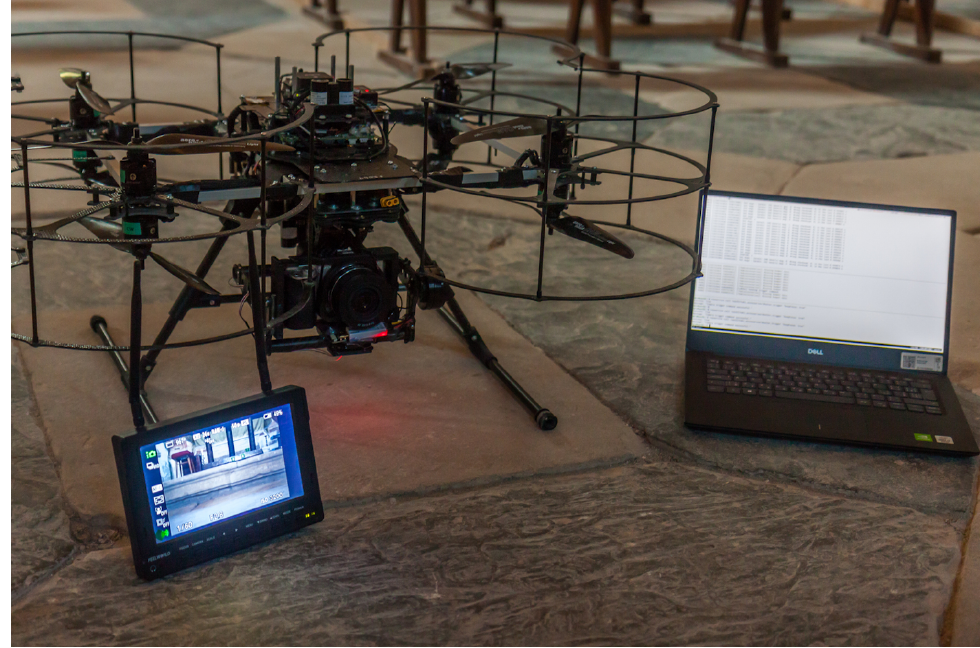
Figure 3. Platform with FPV display for transmission of the camera image to operator and computer for potential camera